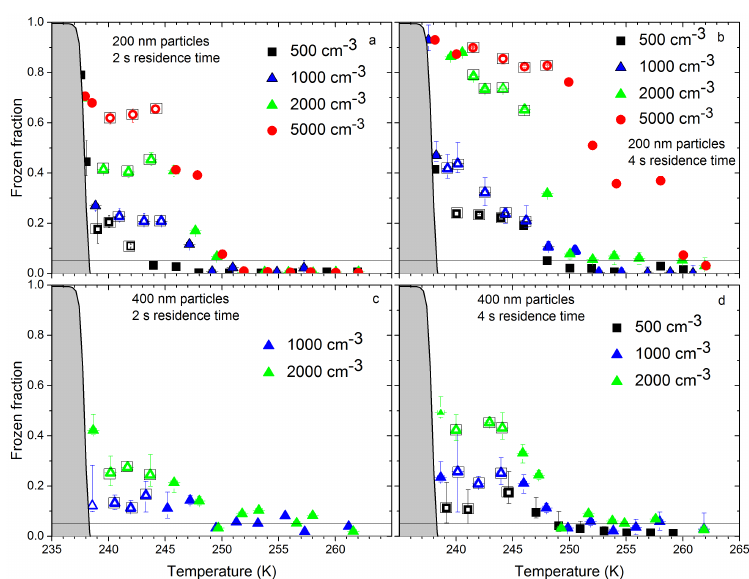
Figure 3. Frozen fraction against chamber temperature for droplet residence times of 2s (a, c) and 4s (b, d) for different concentrations of silver iodide and two different sizes (200nm (a, b) and 400nm (c, d) ). The gray shaded area indicates homogeneous freezing from blank experiments. The horizontal black line indicates the detection limit of the detector determined from the blank experiments. Open symbols indicate the experiments used for the calculation of collision